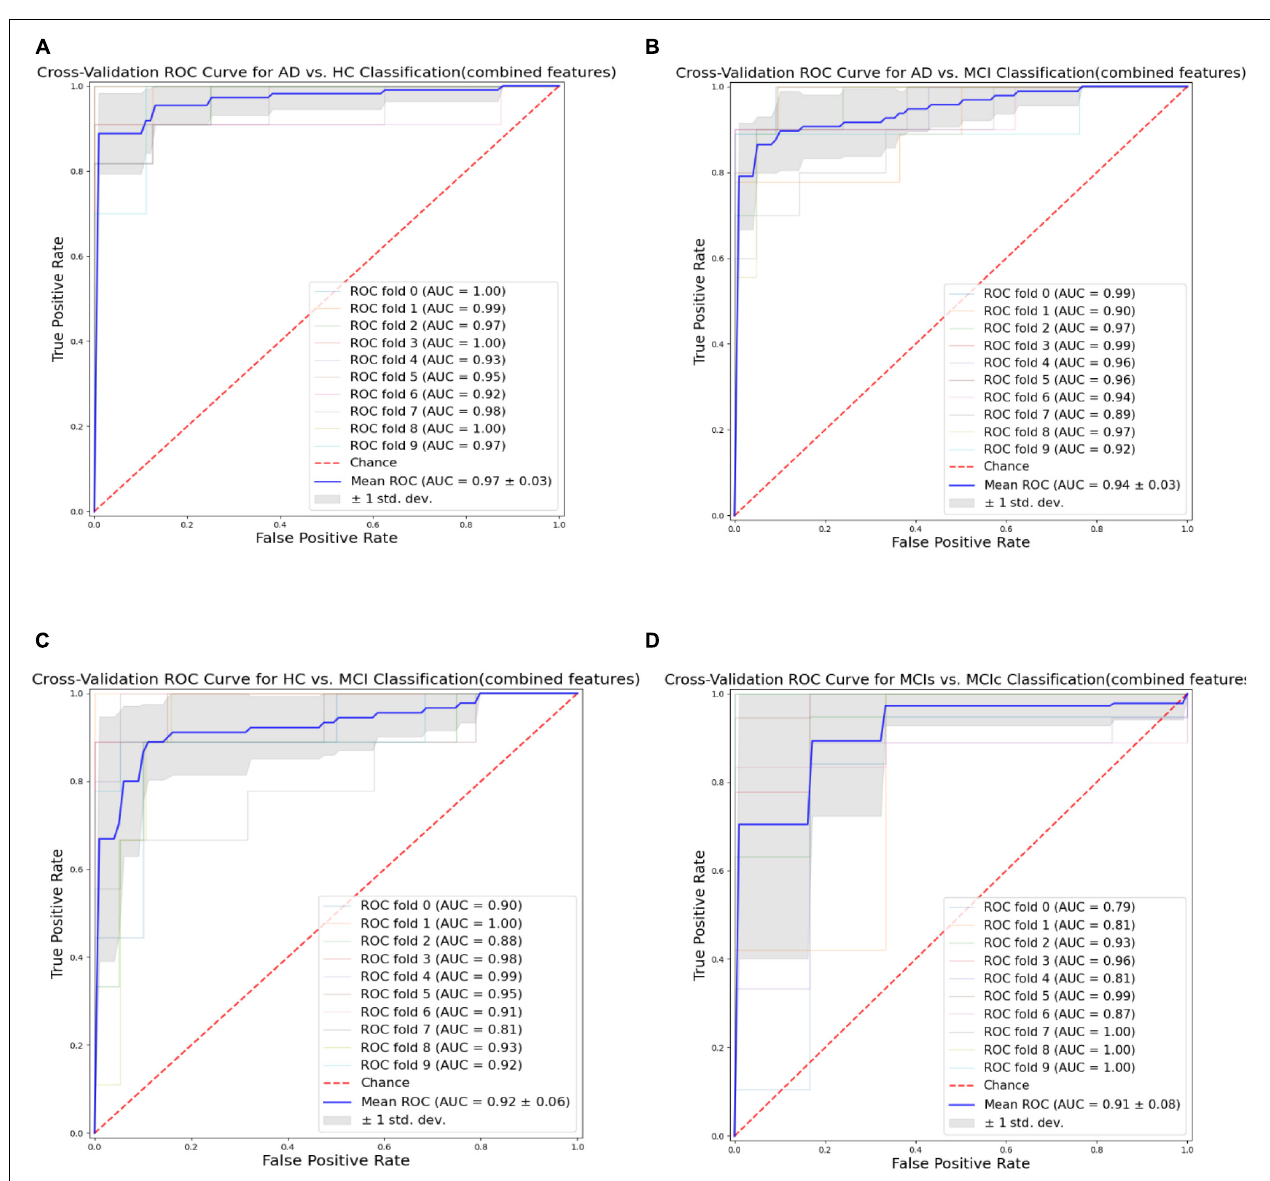
FIGURE 9 | Receiver operating characteristics (ROC) curve for (A) the AD vs. HC group, (B) the AD vs. MCI group, (C) the HC vs. MCI group, and (D) the MCIs vs. MCIc group for combined features vectors: Hippocampus, amygdala, brain network (BN), and voxel